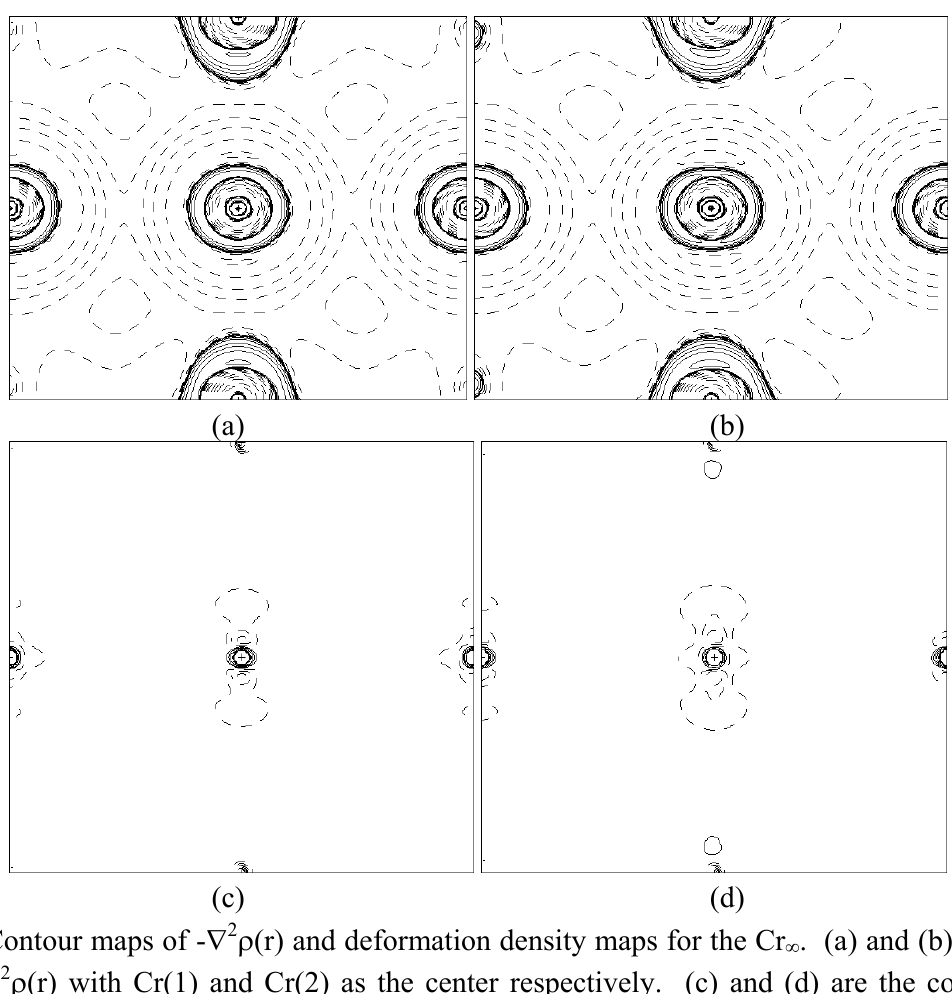
. (a) and (b) are contour ∞